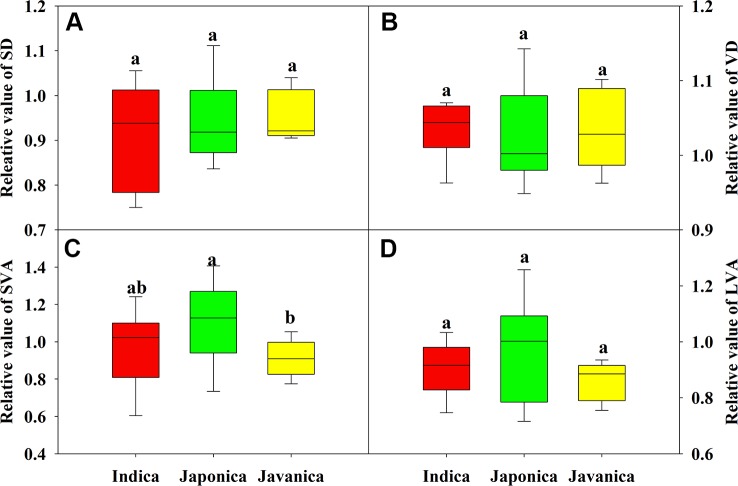
Relative value (HT/CK) of stomatal density (SD, A), vein density (VD, B), and vein area of minor (C) and major (D) veins for the three rice (Oryza sativa L.) subspecies. Different lowercase letters indicate significant differences between subspecies means (p < 0.05). The outer box edges represent the 25th and 75th percentiles, the error bars are the 5th and 95th percentiles, and the line within the box represents the mean values. For each cultivar, three flag leaves were measured (one leaf per plant), and the three values were averaged as one biological replicate. n (the biological replicates) was 8, 8, and 5 for the indica, japonica, and javanica cultivars, respectively.